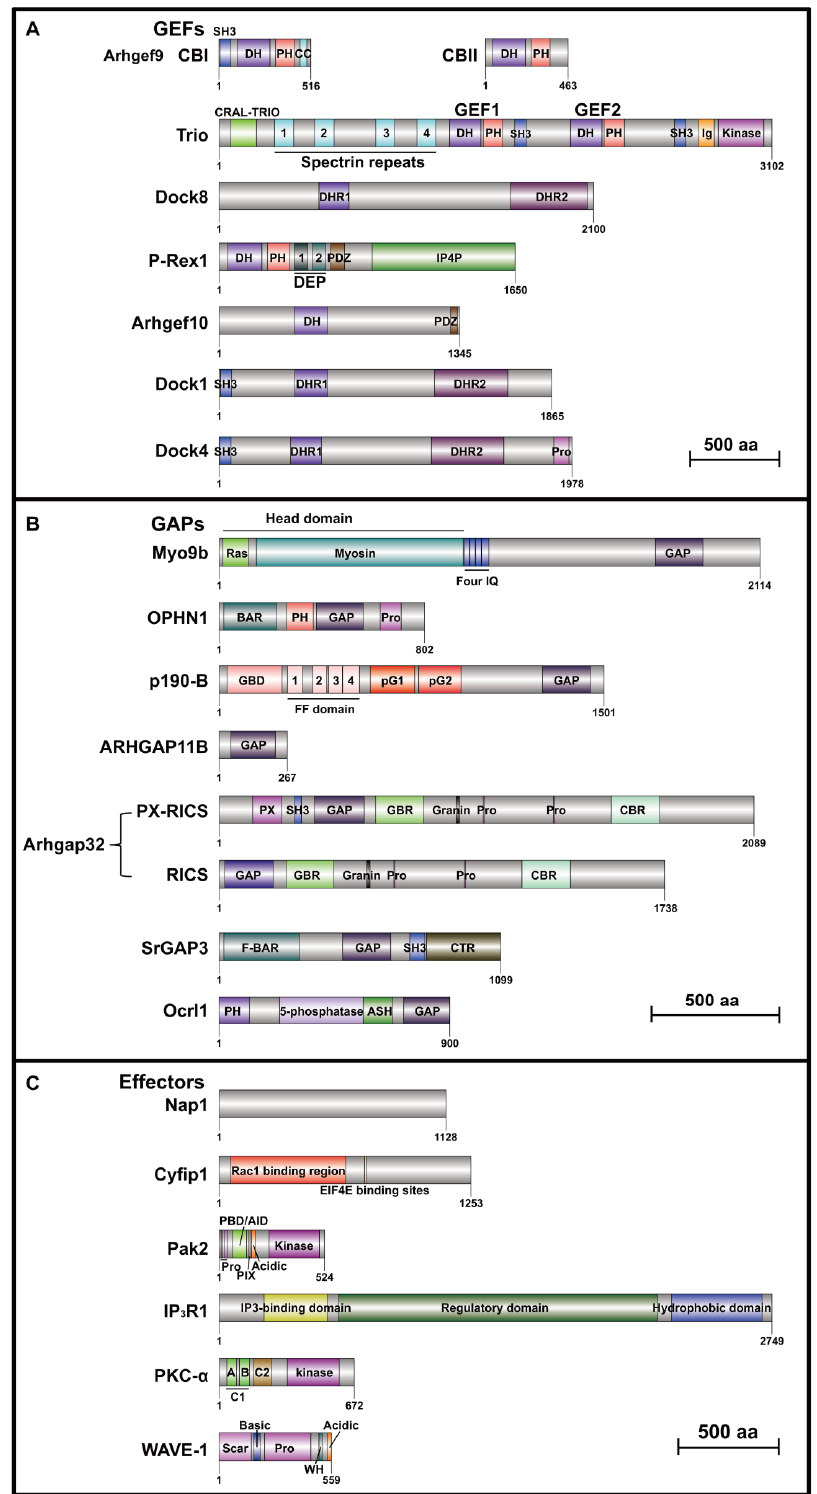
10 Figure 2. Schematics of protein domain structures of 20 ASD-related RhoGEFs, RhoGAPs, and Rho effectors. ( A ) Seven ASD-related RhoGEF protein domain architectures. Arhgef9 (which has two